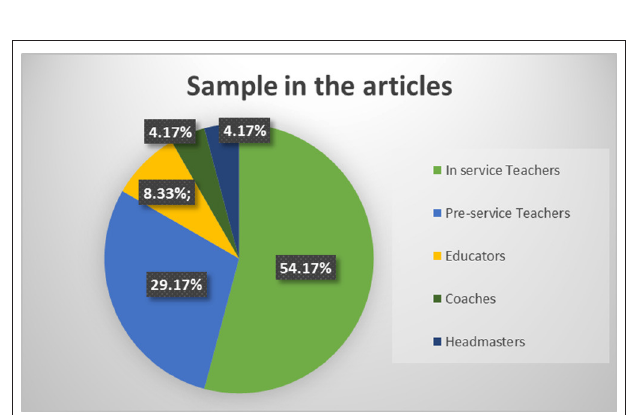
FIGURE 5 | Percentage of articles by